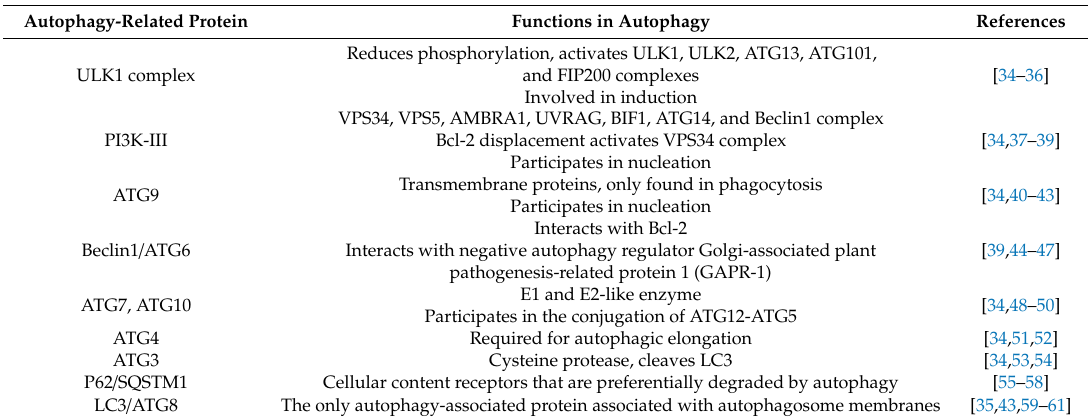
Table 1. The main functions of autophagy-related